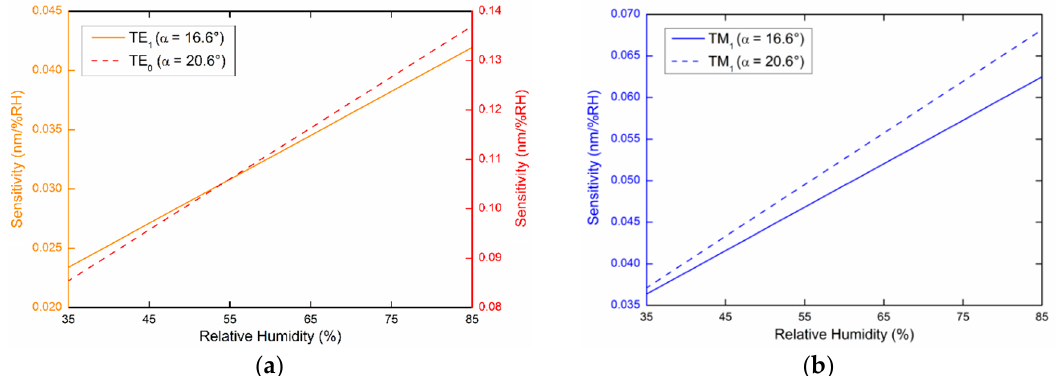
Figure 14. Sensitivities of guided modes measured at external angles of incidence 𝛼 = 16.6° ( a ) and 𝛼 = 20.6° ( b ).